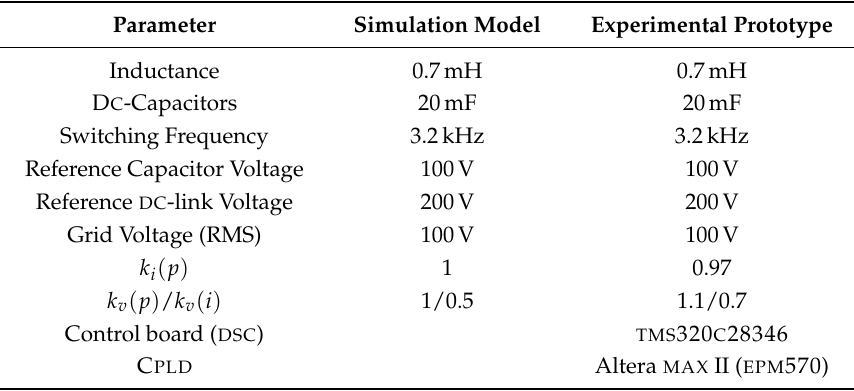
Table 3. System Parameters of CCHB inverter.